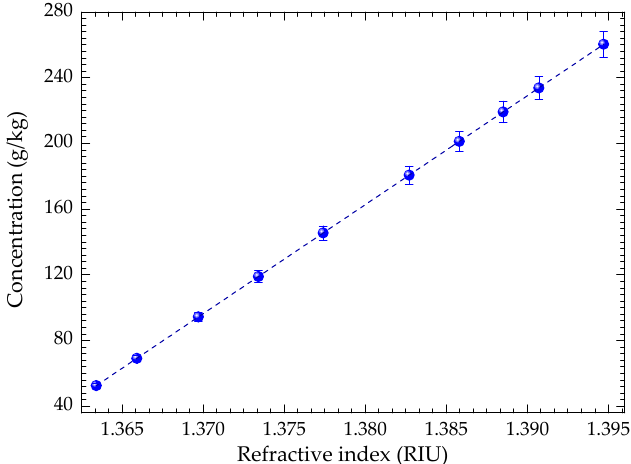
Figure 2. Paracetamol concentration dependence on the refractive index.